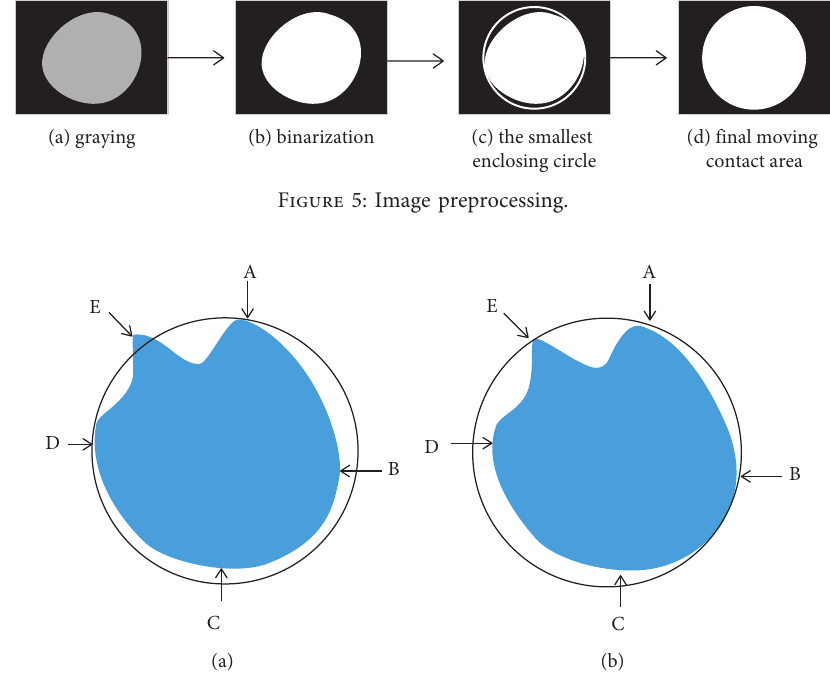
Figure 6: The smallest enclosing circle: (a) the schematic diagram of the first encirclement; (b) the schematic diagram of the second encirclement. A, B, C, D, and E are the end points of the graph, respectively.